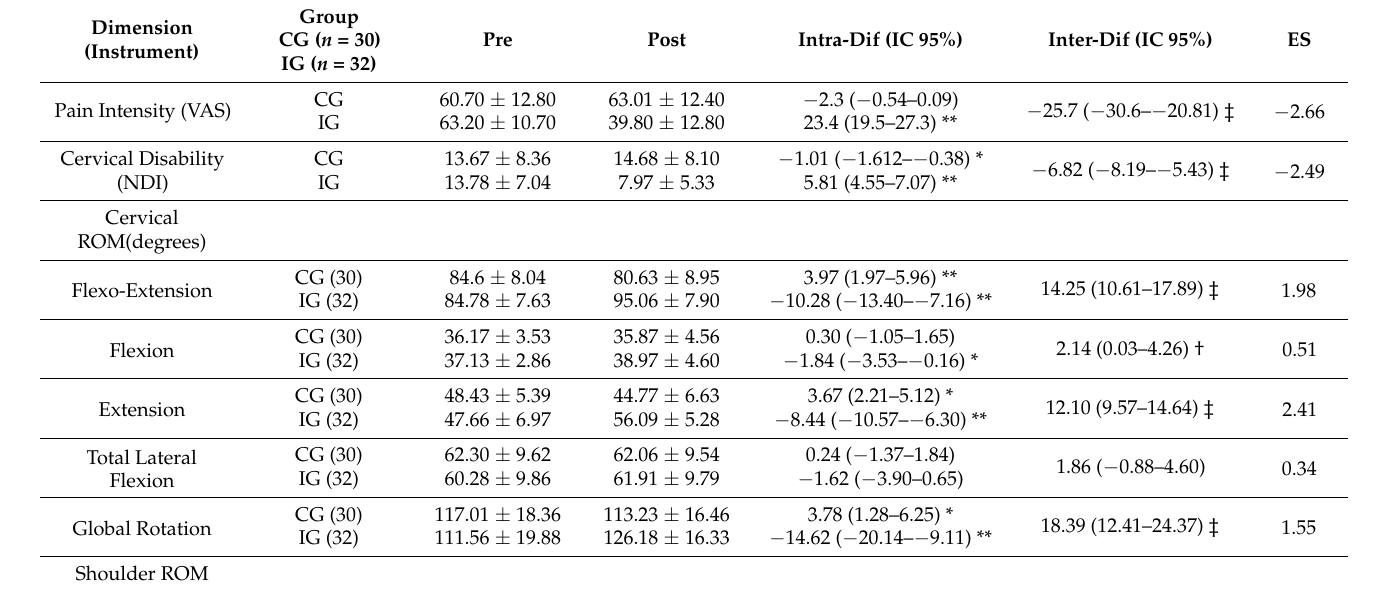
Table 3. Intervention Results (media ± standard deviation) of pain intensity, lumbar and cervical disability, anterior trunk flexibility, shoulder and cervical ROM, maximal hand grip, and abdominal and lower limb strength-resistance